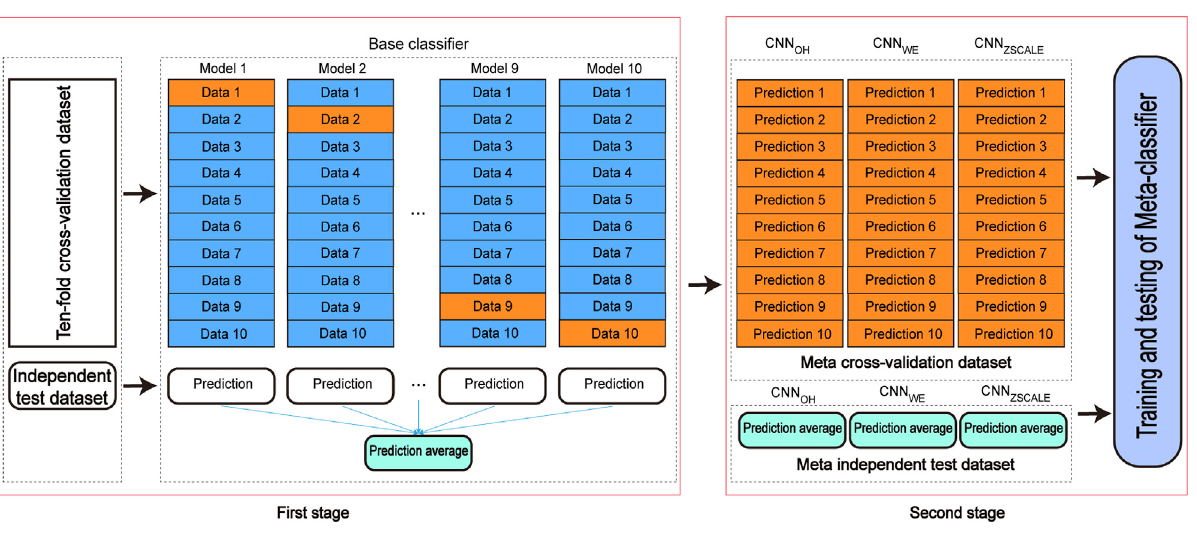
FIGURE 8 The architecture of the two-stage stacking ensemble classi fi